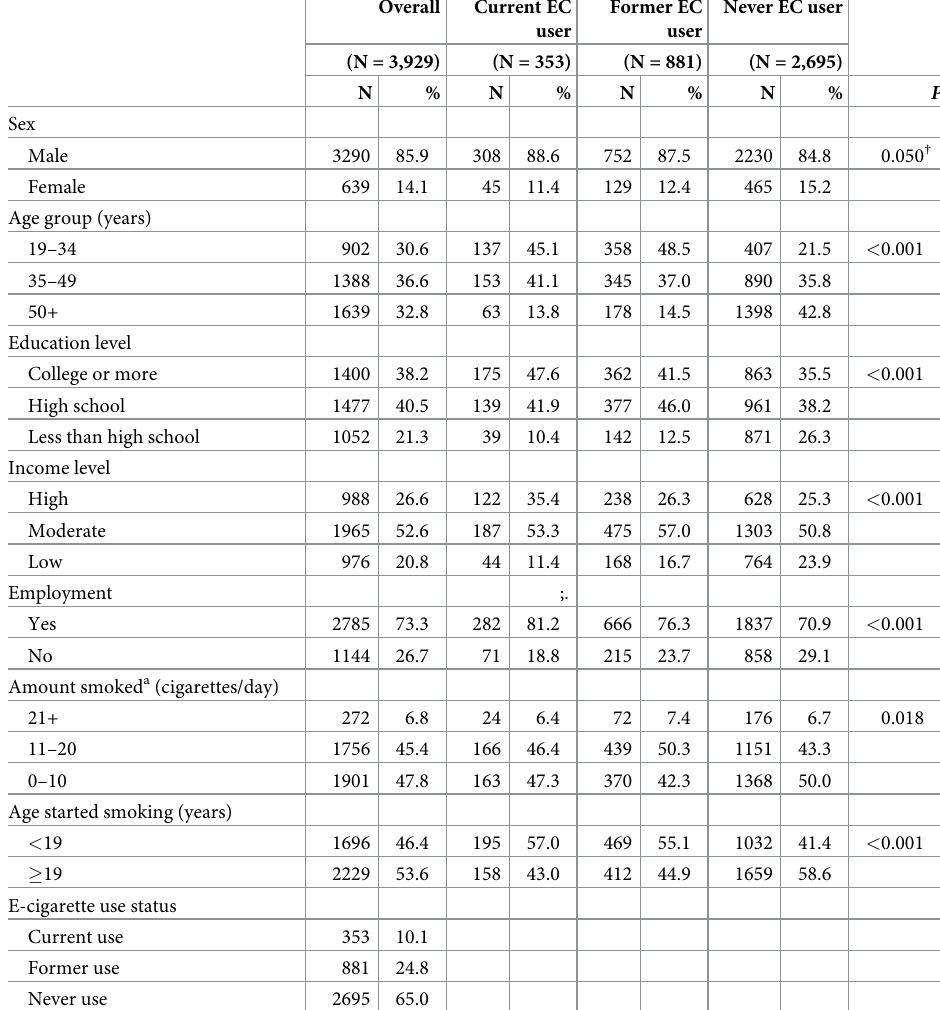
Table 1. Demographics and smoking characteristics, overall and by e-cigarette use